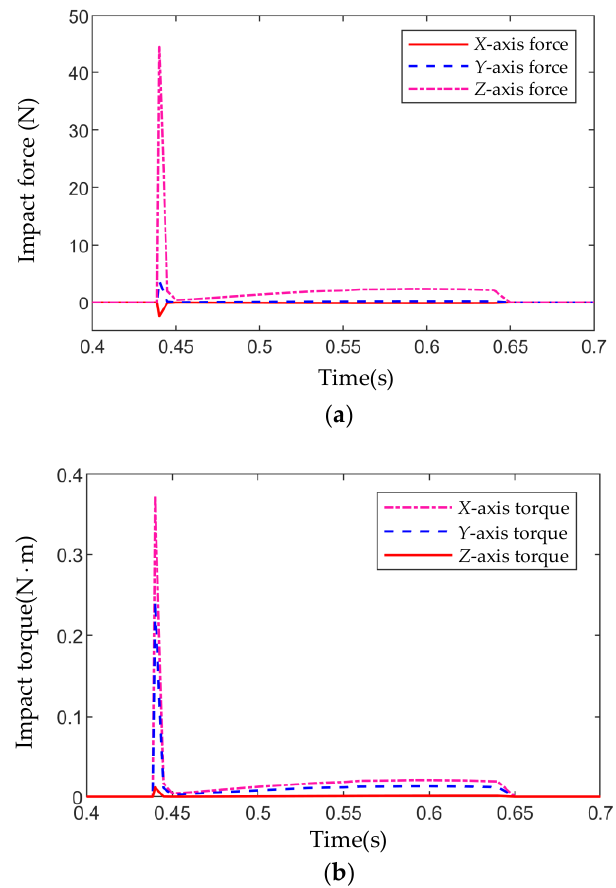
Table 4. The selected parameters of the controller.